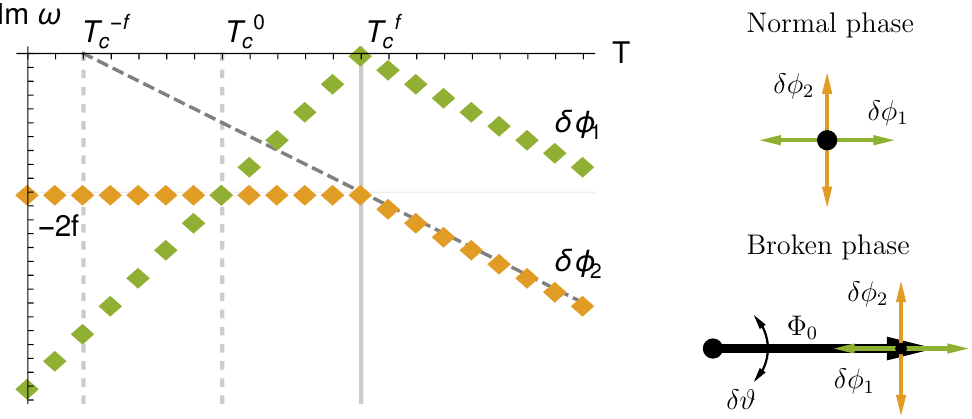
Figure 1. Right panel. The roles of the fluctuations of real δφ 1 and imaginary δφ 2 modes of the complex scalar (2.2). In the normal state they are degenerate and related by U(1) rotation. In the broken state characterized by real order parameter Φ of the order parameter, while mode δφ Left panel. The dynamics of the δφ 1 , 2 modes across the U(1) phase transition coming from the time dependent Ginzburg-Landau analysis (2.7) in presence of explicit symmetry breaking term f . The critical temperature is shifted by the external force ( T 0 the two instability driving modes is resolved (2.8). Below T f Goldstone